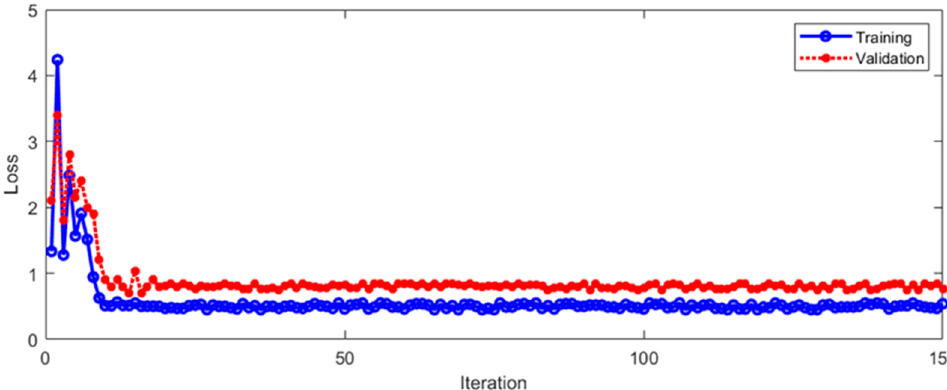
Figure 16. The LOSS of Method 2 during training and verification.